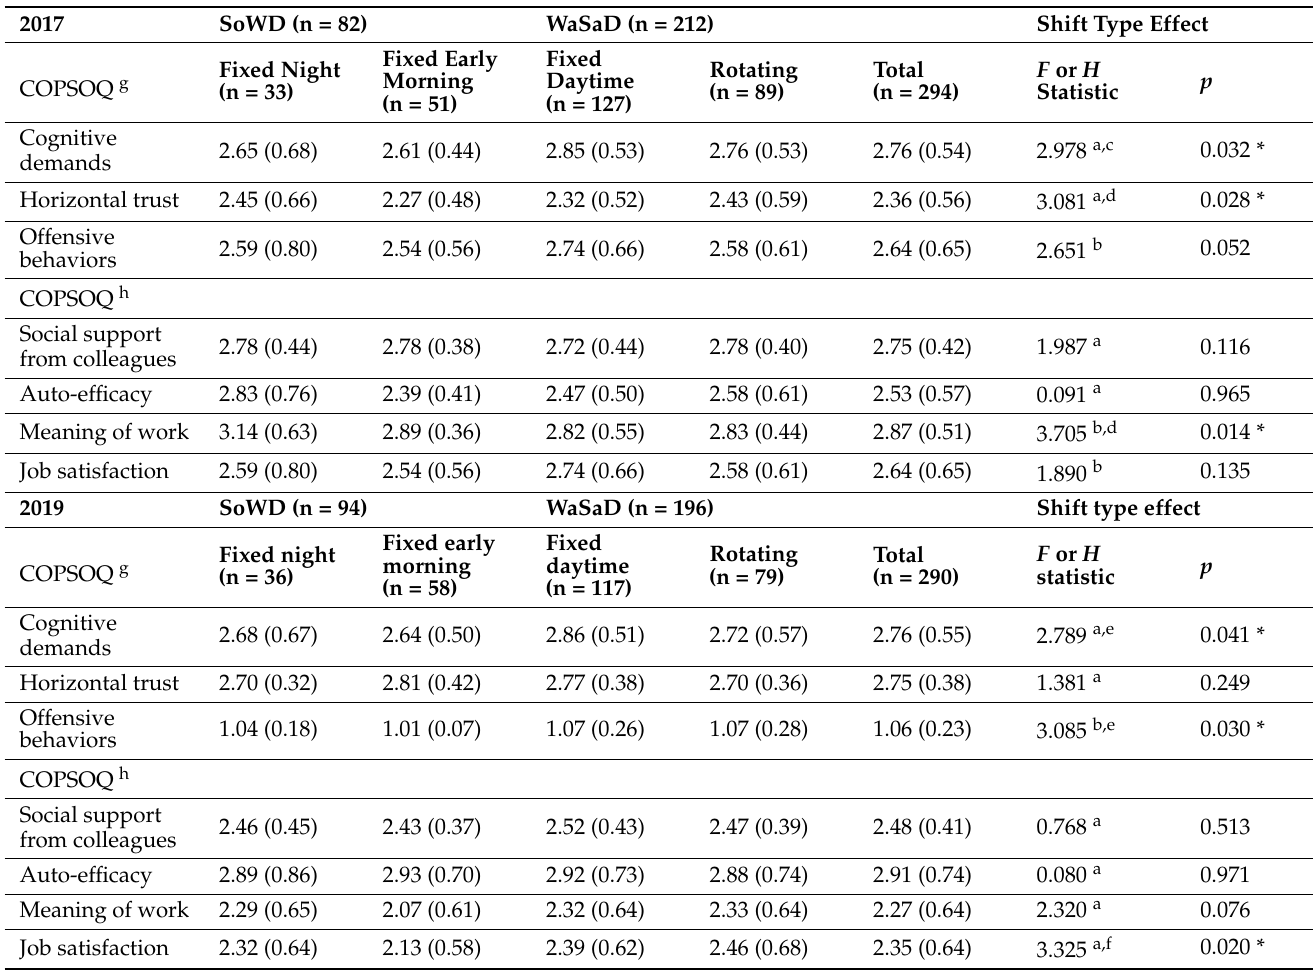
Table 5. Mean (SD) of psychosocial variables in 2017 and 2019 by shift type, and shift type